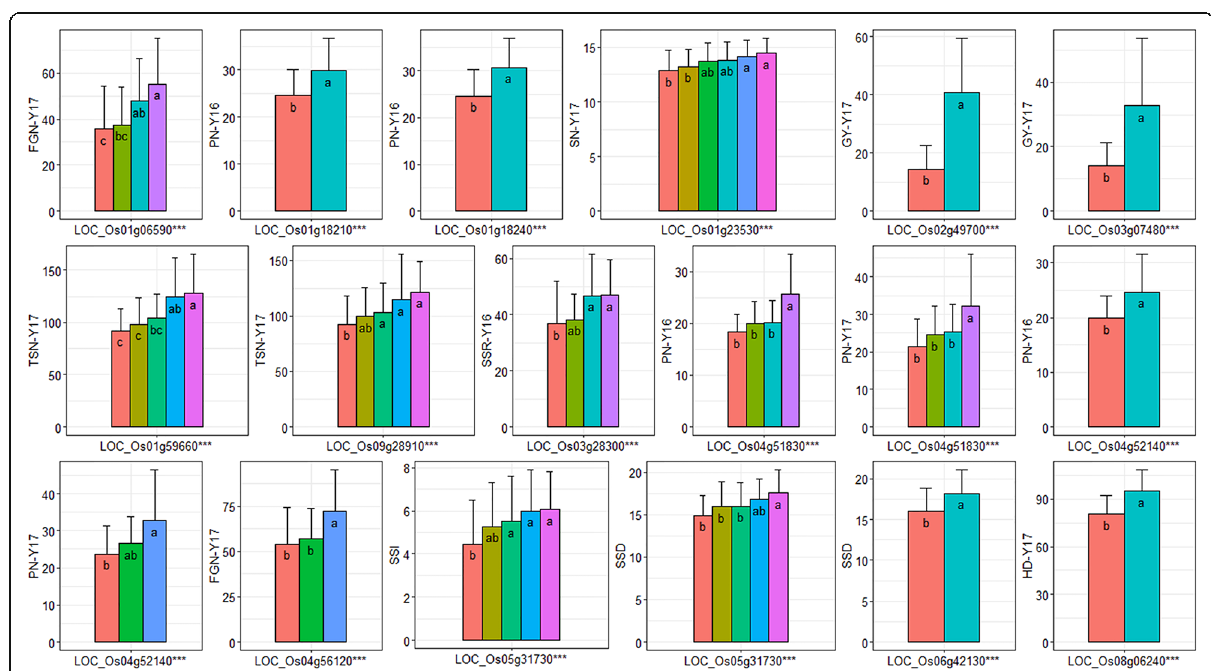
Fig. 4 Haplotype analysis of the 15 promising candidate genes for rice salt tolerance. The colors of the bars indicate the different haplotypes for